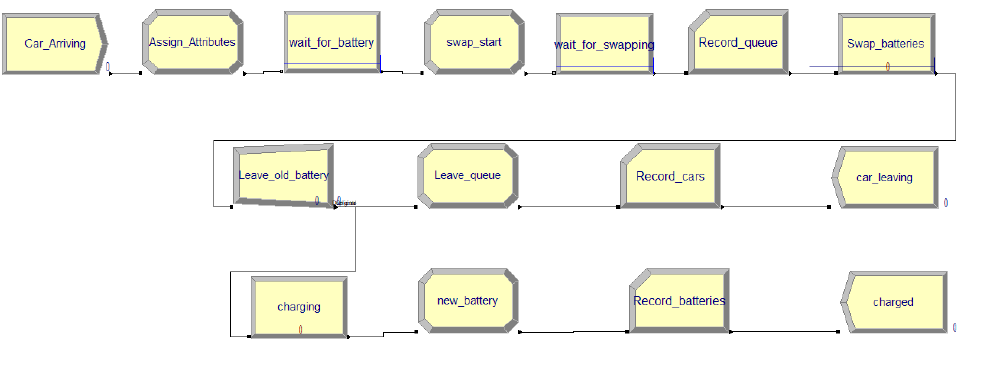
Figure 4. The simulation model of a single station in